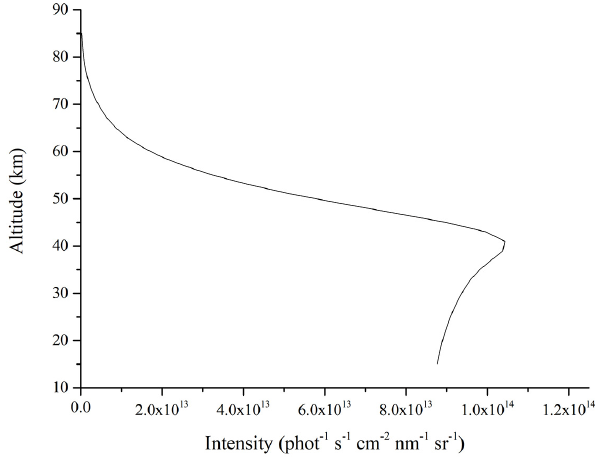
Figure 7. An observed radiance profile obtained by the modified SCIATRAN.